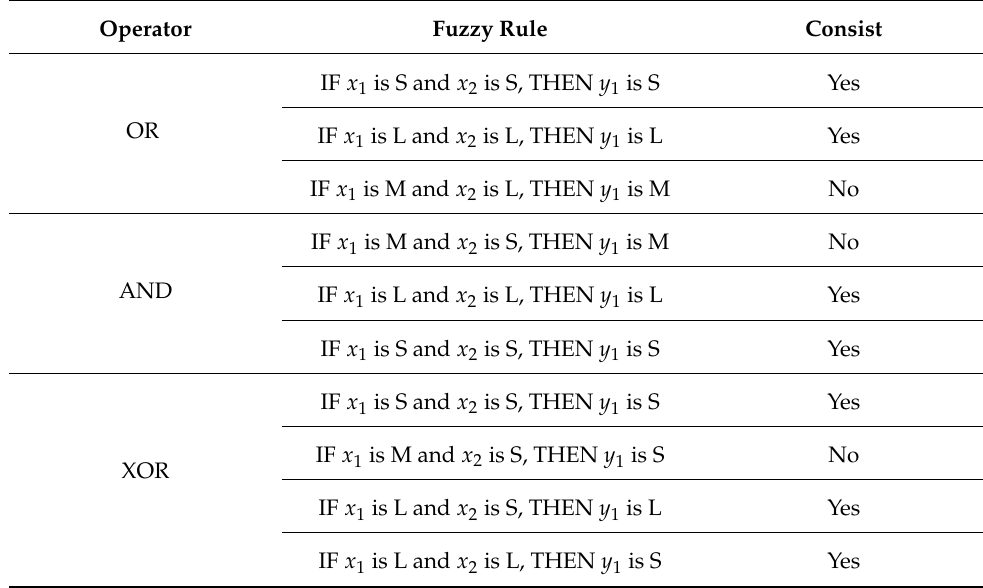
Table 4. Fuzzy rules generated from discrete data sets with iDRF-1.